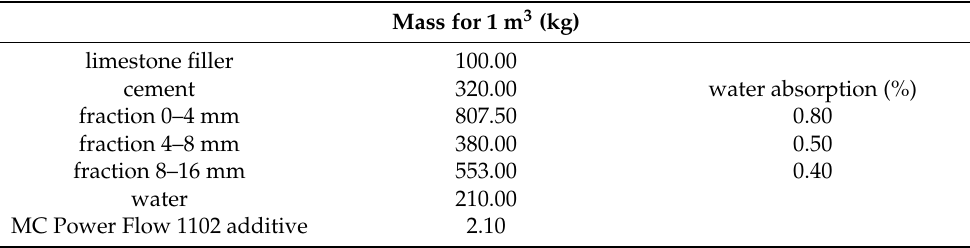
Table 2. Concrete